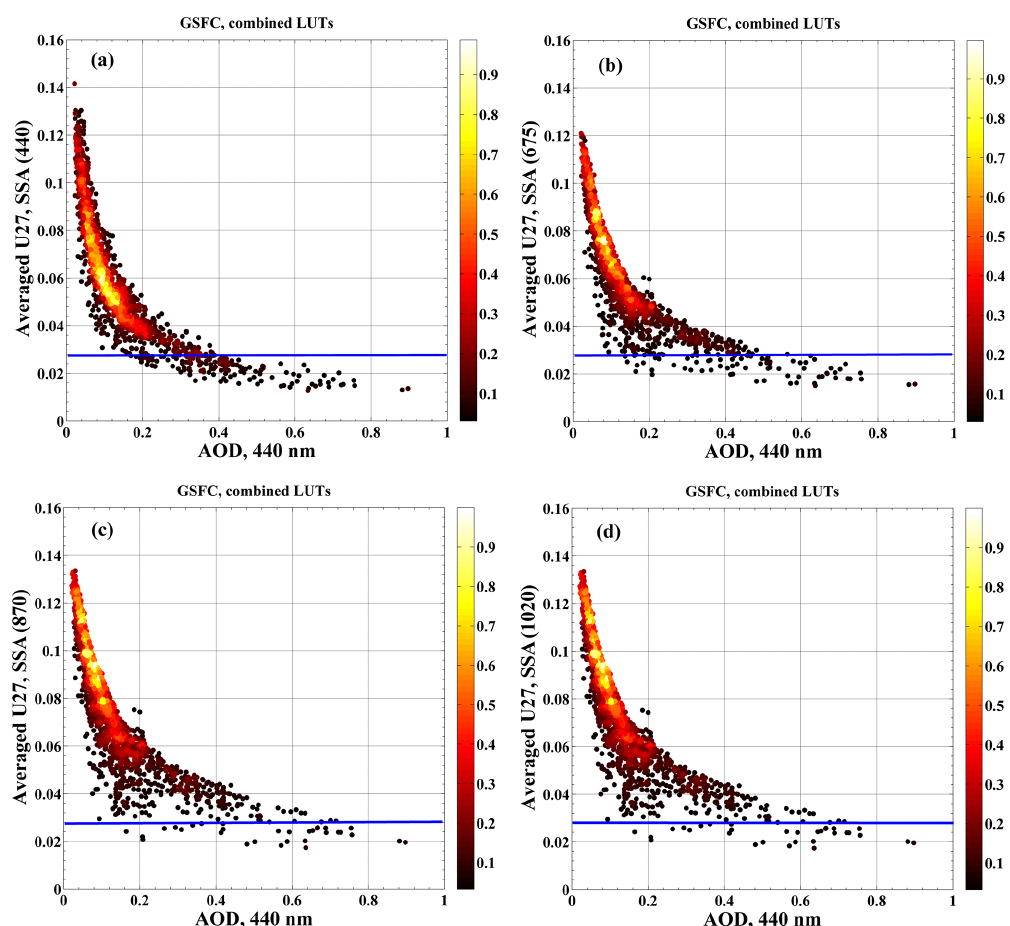
Figure 20. Uncertainties for SSA retrievals at the GSFC site: (a) 440, (b) 675, (c) 870, and (d)